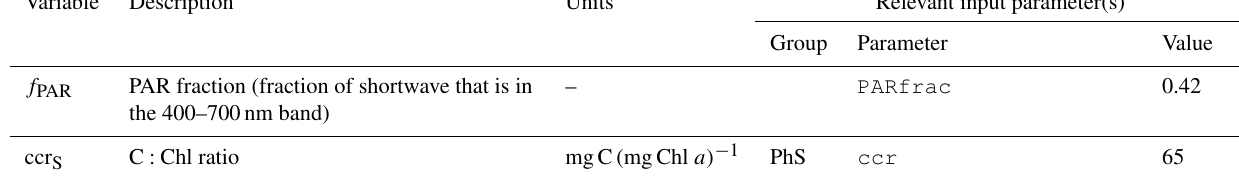
Table A4. Notation and description for input parameters related to light attenuation.